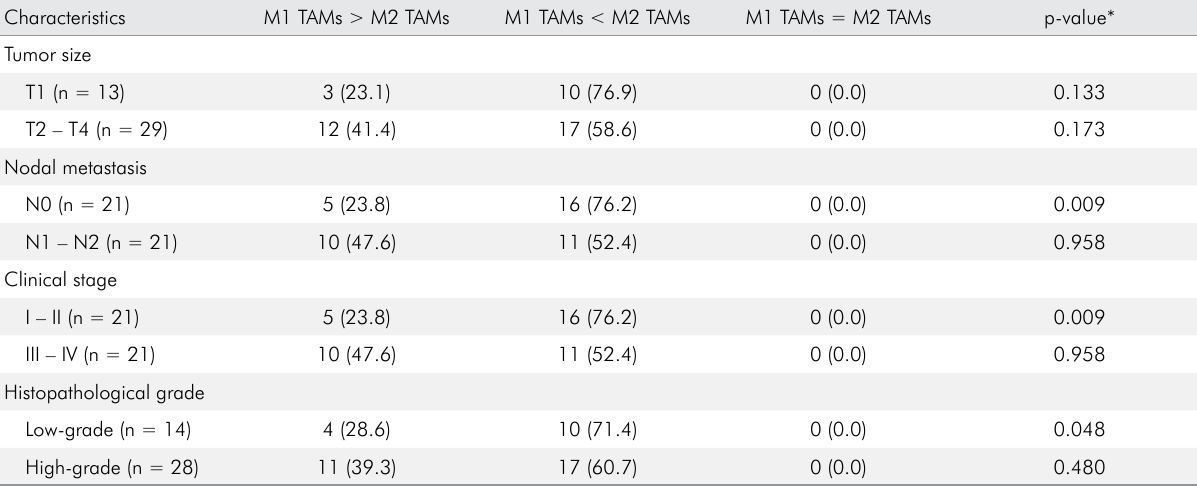
Table 3. Distribution of cases of lower lip squamous cell carcinoma according to ranks of M1 and M2 TAMs [n (%)] and clinicopathological